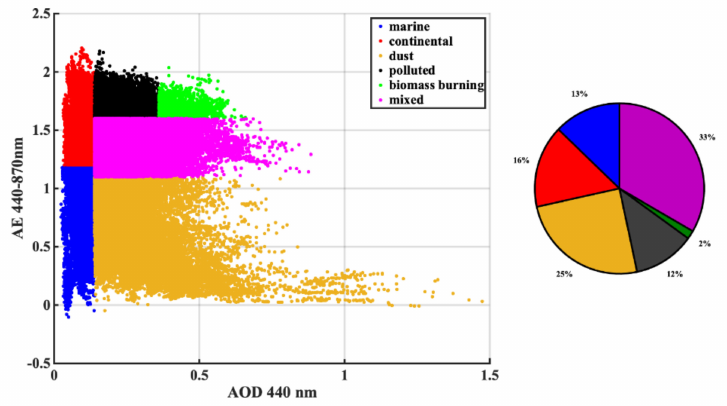
Figure 4. Aerosol classification for the CUT-TEPAK station at Limassol.